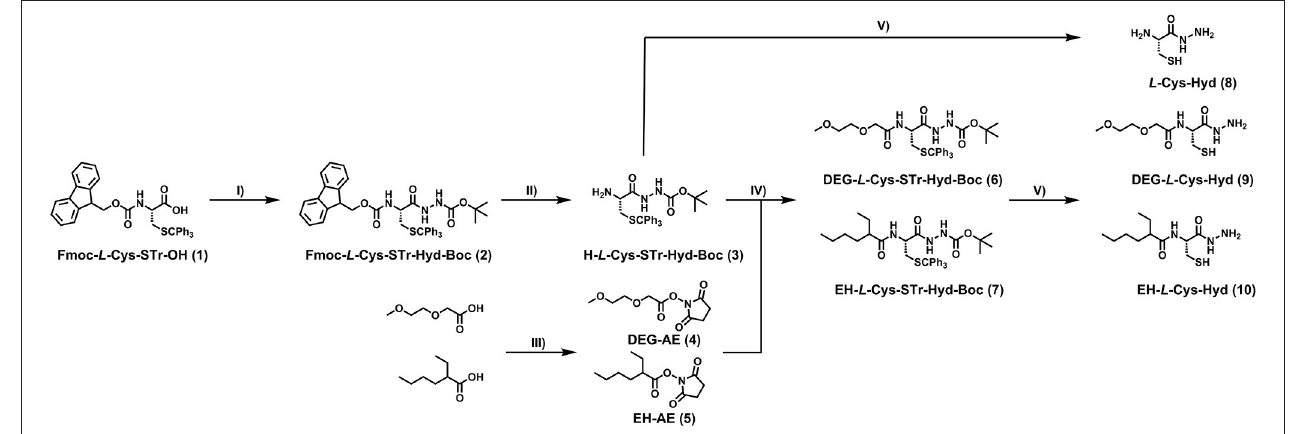
FIGURE 2 | Synthesis of modified cysteine hydrazides. Reagents and conditions: (I) tert -butyl carbazate, EDC · HCl, HOBt, Et 3 N, DCM, 0 ◦ C to rt; (II) DMF/piperidine (8:2v.v.), rt; (III) DCC, NHS, THF or DCM, r.t; (IV) Et 3 N, DMF, r.t.; (V) TIS/TFA (90:10v.v.). See experimental section for